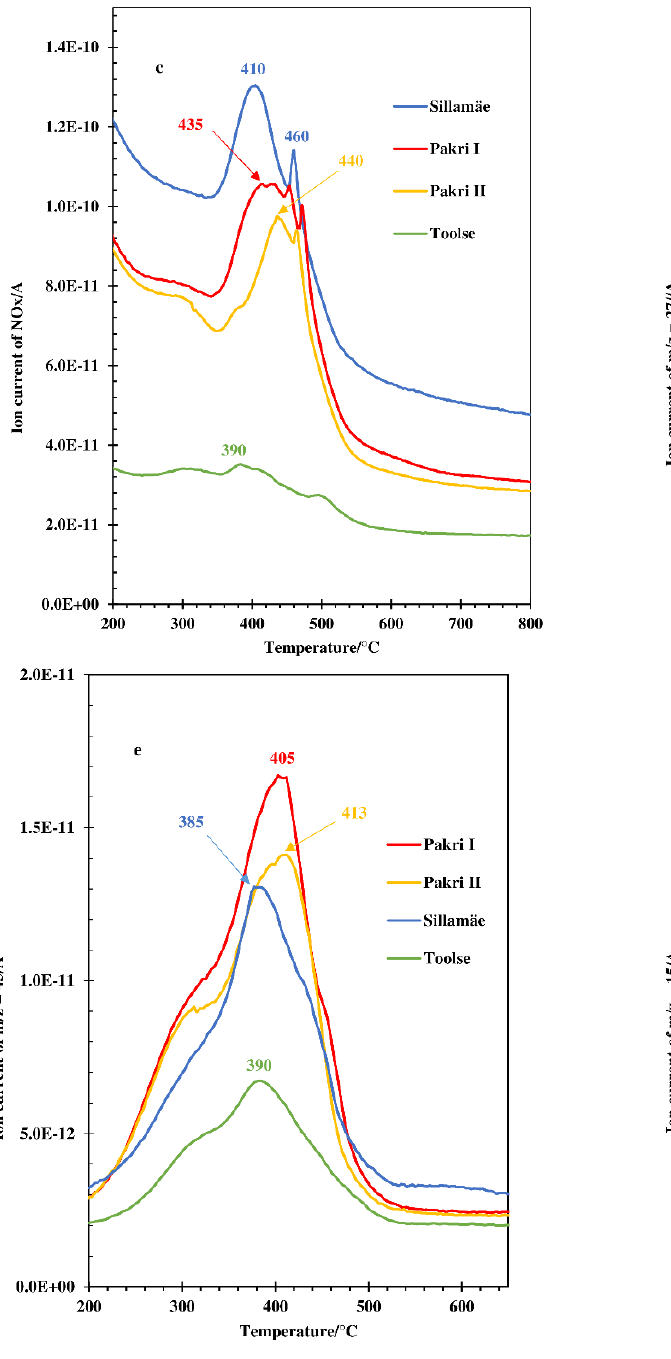
Figure 3. Emission profiles of H 2 O ( a ), CO 2 ( b ), NOx ( c ), hydrocarbon fragments with m / z = 27 ( d ), m / z = 45 ( e ), m / z = 15 ( f ), and SO 2 ( g ) emitted at thermal treatment of GA samples. 3.2. FT-IR, XRD and Morphology Analysis For characterization of the influence of the treating temperature on the mineralogical composition of GA samples studied, the FT-IR spectroscopic and XRD methods were ap- plied. Certain differences in FT-IR spectra of different GA samples can be followed de- pending on the mineralogical composition of the samples (Figure 4a,b). The band at around 3410 cm −1 is characteristic of OH stretching, and 1620 cm −1 is characteristic of the OH bending vibration of structural hydroxyl groups, in clay minerals and absorbed water, respectively [45–47]. The asymmetric stretching vibration band at 1420 cm −1 , the out-of- plane bending vibration band at 875 cm − 1 , and the in-plane bending vibration band at 712 cm −1 are characteristic of the CO 32 − ion [48,49], indicating the content of carbonates in GA samples, being especially intense for Sillamäe GA. In addition, in the FT-IR spectra of the